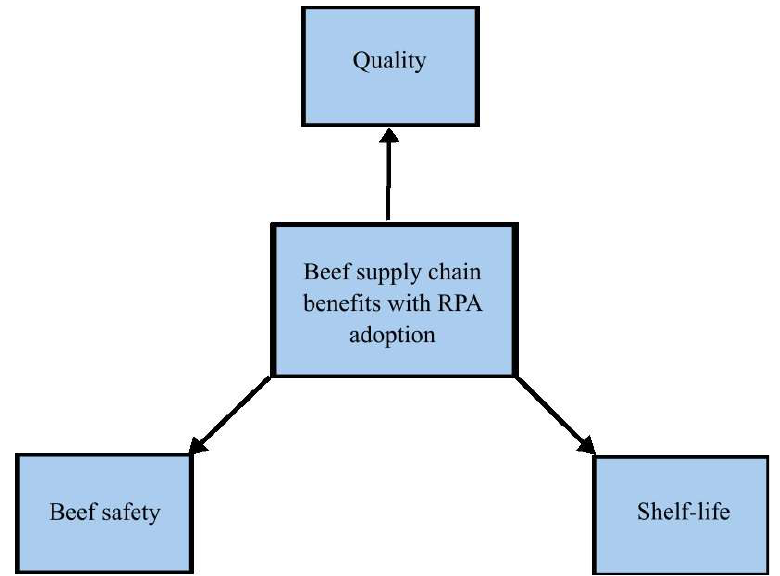
Figure 3. The relationship between factors. A process model is created in the Simul8 software and simulation of the process model saw operational efficiency, capacity and shelf-life of the beef processed. Furthermore, the process model highlights various stages of the beef supply chain adapted from real-life supply chains. There are various processes mentioned in the beef supply chain and those processes are as such displayed in the model. Thus, the process model depicts the entire beef processing process until it reaches the end consumer. The data are collected using available secondary information based on the beef supply chain’s stages and Robotic Process Automation adoption in its various phases. Thereafter, the data are analysed in Simul8 through a simulation approach. The following Table 3 projects the key processes or stages of a functioning beef supply chain. The process model includes all the stages observed in Table